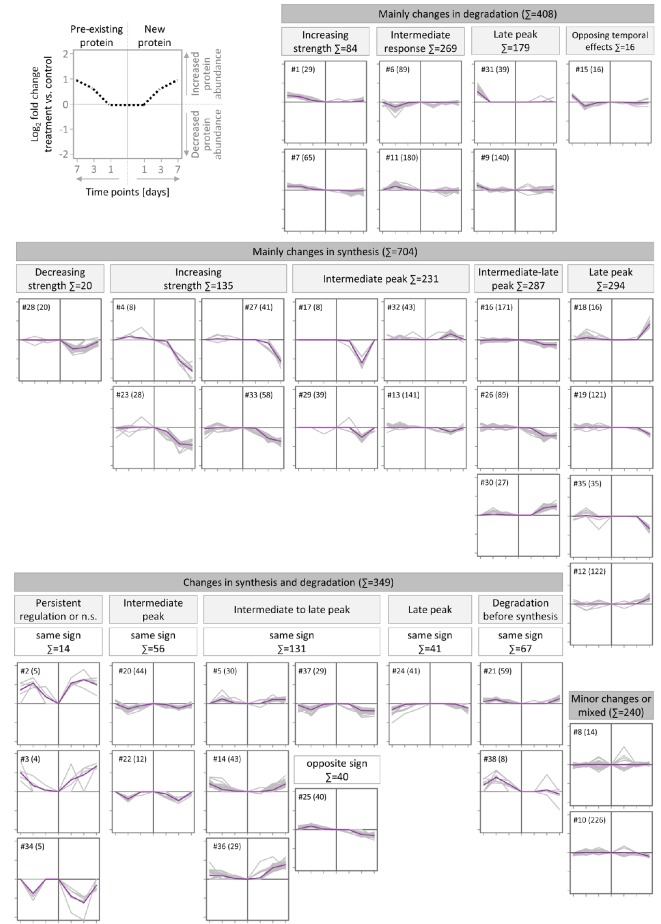
Clusters of temporal protein profiles observed during TTX-induced up-scaling. Proteins were clustered using their temporal profiles of pre-existing and newly synthesized proteins by kmeans clustering. For each cluster, the temporal profiles of all members are shown in gray and the average profile is shown in green. The cluster number (#) and number of protein members (in brackets) are indicated. Clusters with similar profiles were manually assigned to upper-level groups. The schematic in the top left panel provides the axis information for the displayed clusters. The dashed line represents the temporal profile of an exemplary protein.